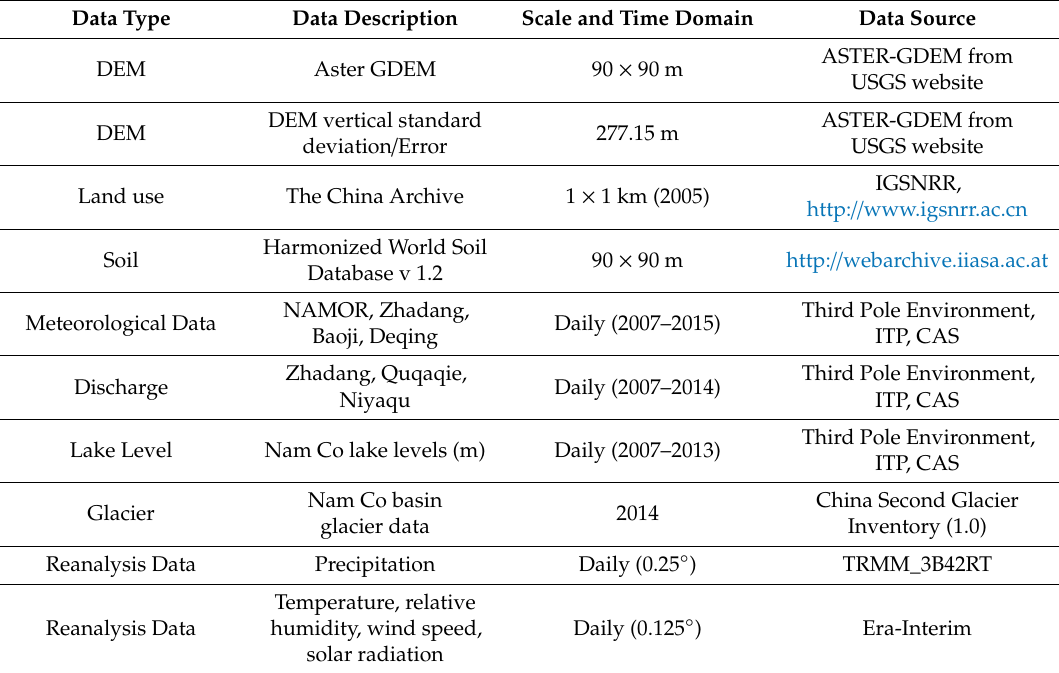
Table 1. List of datasets used in this